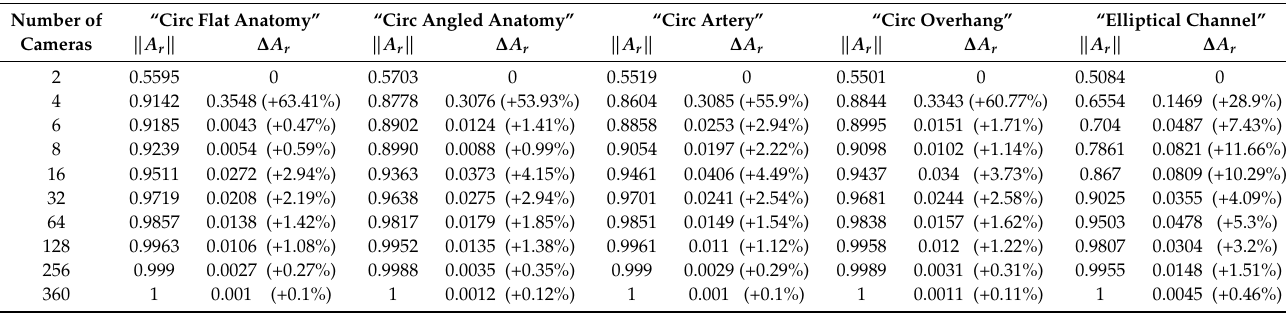
Table 2. Reconstructable areas ( A r ) of the 50mm channel models for different numbers of cameras, including the top surface. The area values for each mesh are normalized to the area of the respective mesh which is reconstructable with 360 cameras. ∆ A r denotes the increase in reconstructable area from the next smaller number of cameras.